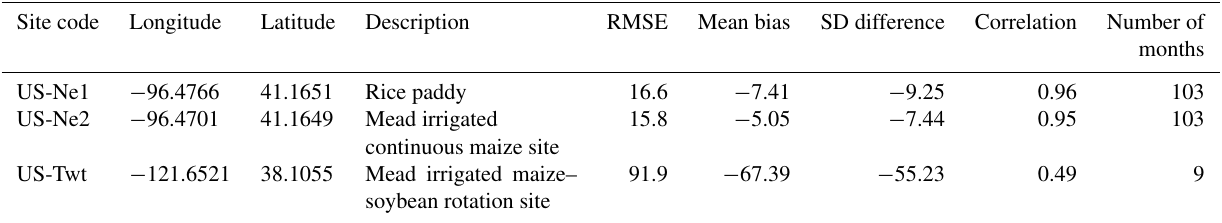
Table 2. Four metrics (RMSE, mean bias, SD difference and correlation) of DOLCE at three irrigated sites, and the number of available monthly records for each